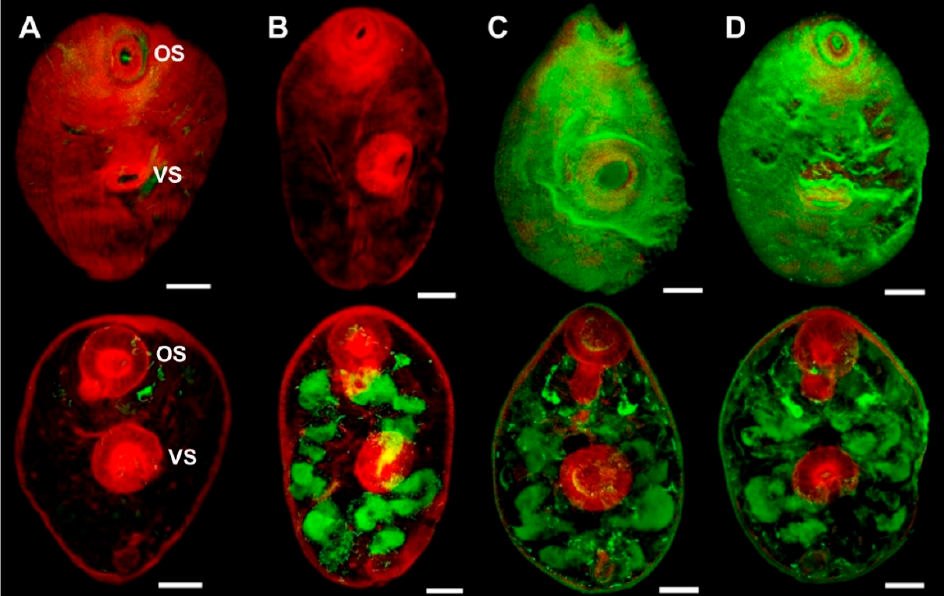
Figure 6. Immuno-localisation of native FhSOD1 and FhSOD3 in newly excysted juveniles (NEJ). Whole-mount F. hepatica NEJ 3 h post-excystment were probed with ( A ) rabbit pre-immune sera (negative control), ( B ) anti-rFhCL3 polyclonal antibodies (non-related positive control), ( C ) anti- rFhSOD1 polyclonal antibodies, and ( D ) anti-rFhSOD3 polyclonal antibodies. Immuno-localisation of native F. hepatica proteins is represented by green fluorescence (FITC staining). All samples were counter-stained with phalloidin-TRITC to stain muscle tissue (red fluorescence). OS; oral sucker, VS; ventral sucker, scale bars; 25 µM.